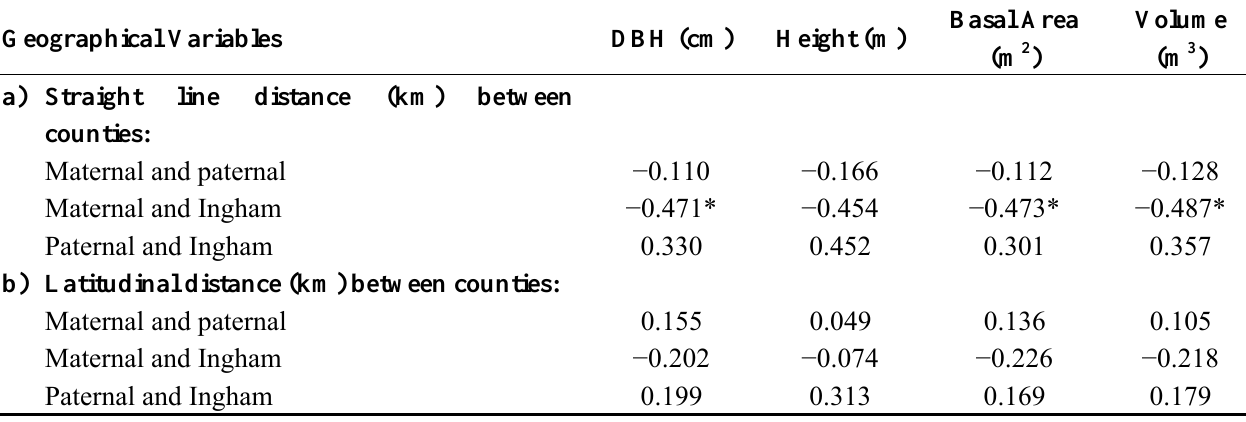
Table 3. Pearson correlation coefficients between growth characteristics of 18 full-sib families of hybrid poplar ( P. × smithii ) and geographical